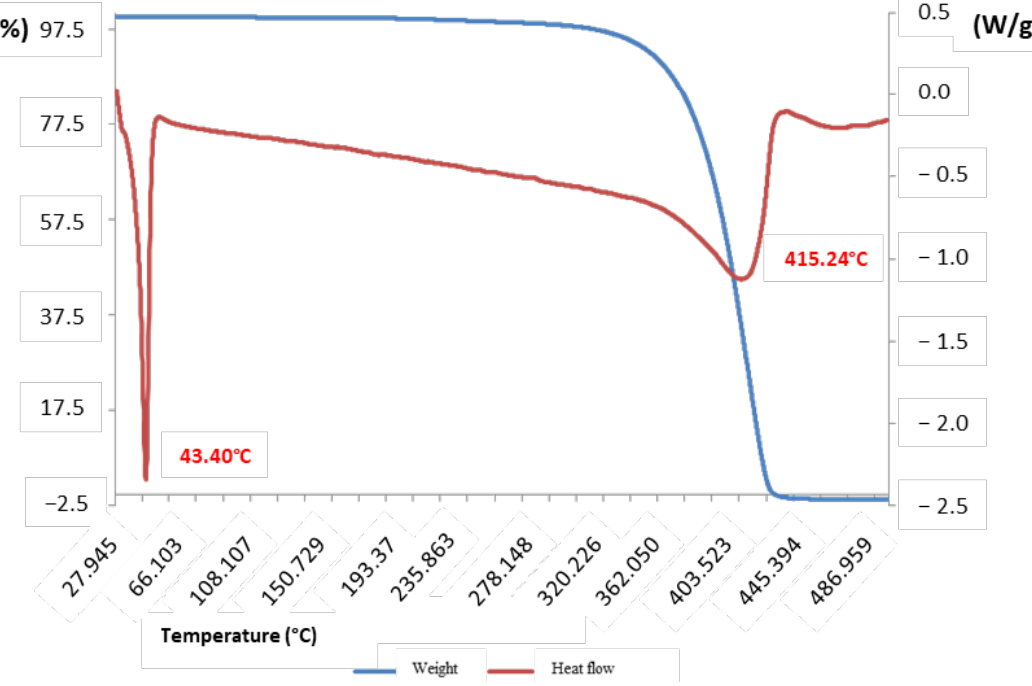
Figure 4. Thermogram obtained by TGA analysis of I. gabonensis butter.